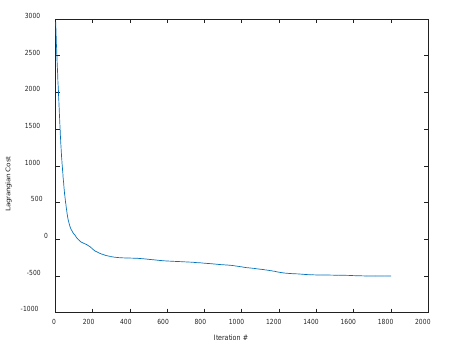
Figure 7: The optimization cost function at every iteration Experiment 2